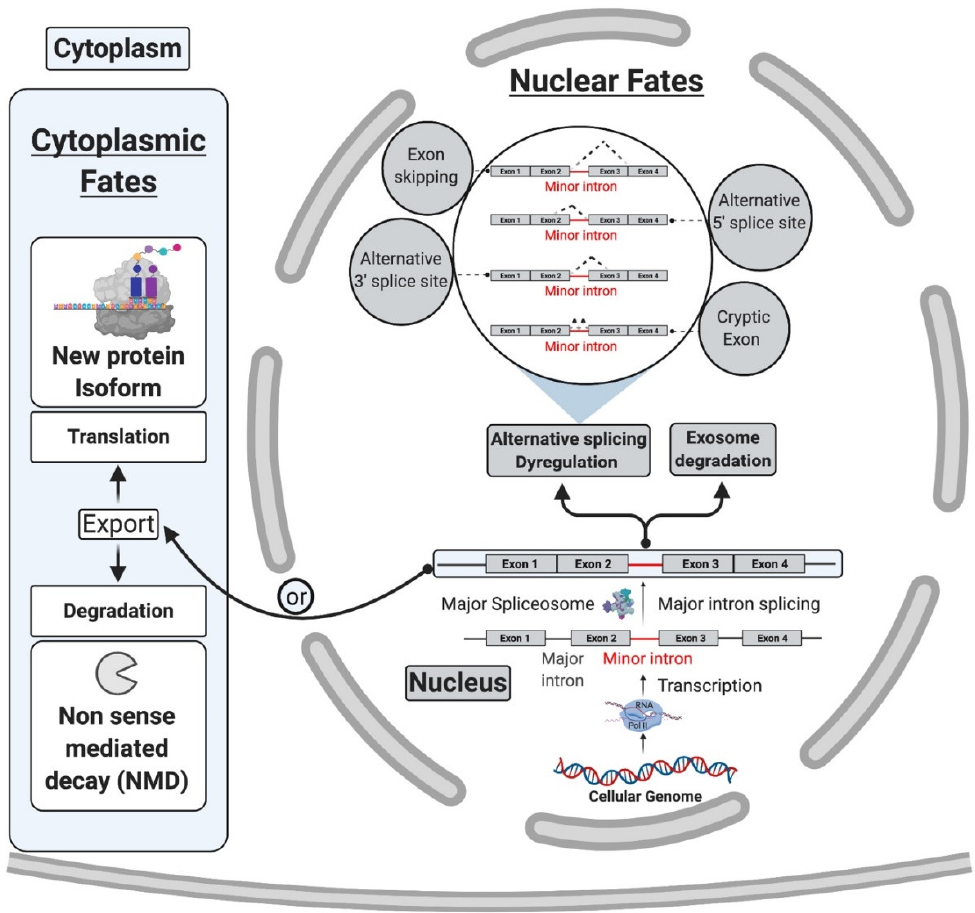
Figure 4. Cytoplasmic and nuclear fates of pre-mRNA transcripts with retained mi-INTs [20,26,27]. mi-INTs retention may lead to trapping of the transcript within the nucleus. The trapped transcript may undergo exosomal degradation, activation of cryptic U2-type intron cryptic sites or exon skipping. Transcripts that escape degradation in the nucleus are exported to the cytoplasm they may be degraded by NMD or translated to a truncated or novel protein isoform.